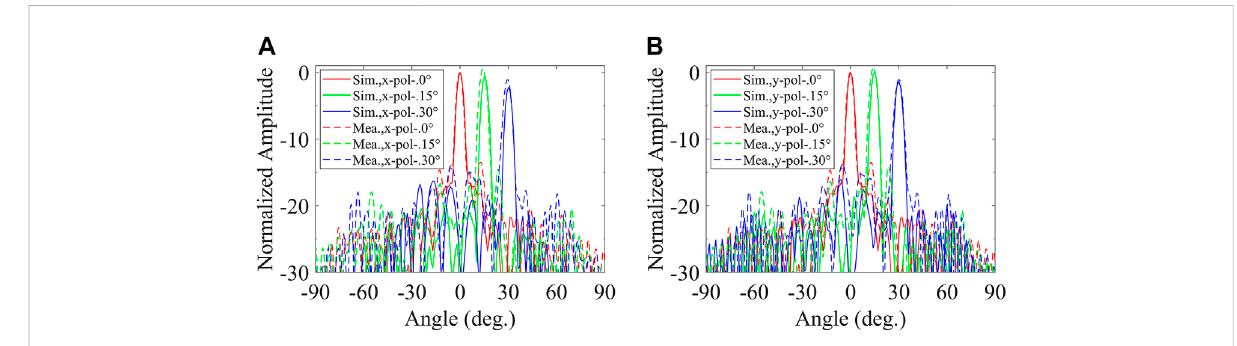
FIGURE 6 The E-plane far- fi eld radiation pattern of 1-bit metasurfaces with the radiated angles of 0 ° , 15 ° , and 30 ° (A) for x polarization and (B) y polarization.